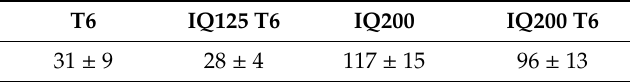
Table 3. Width of the precipitation-free zone, d PFZ (nm).